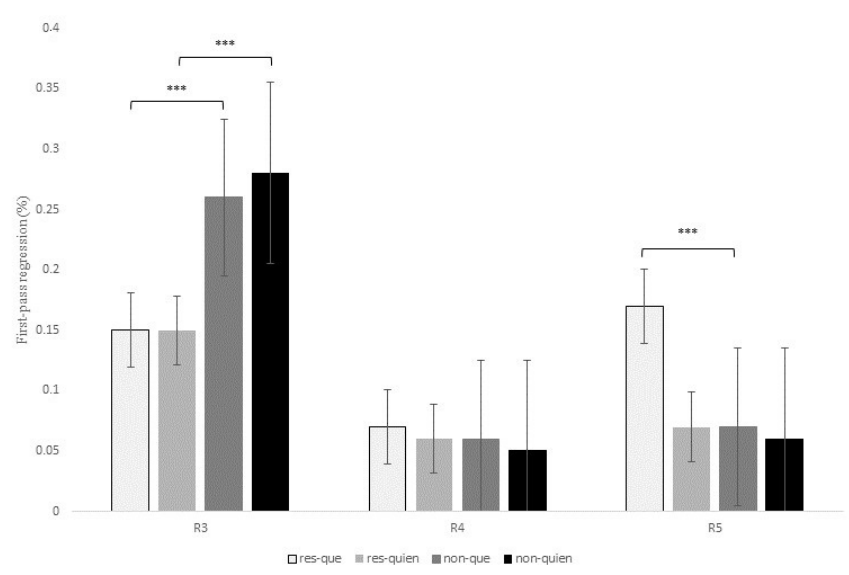
Figure 7. Probability of regression during the first-pass at regions 3, 4, and 5 for the contrast que versus quien in restrictive and non-restrictive RCs. Asterisks indicate that an effect is significant at p <